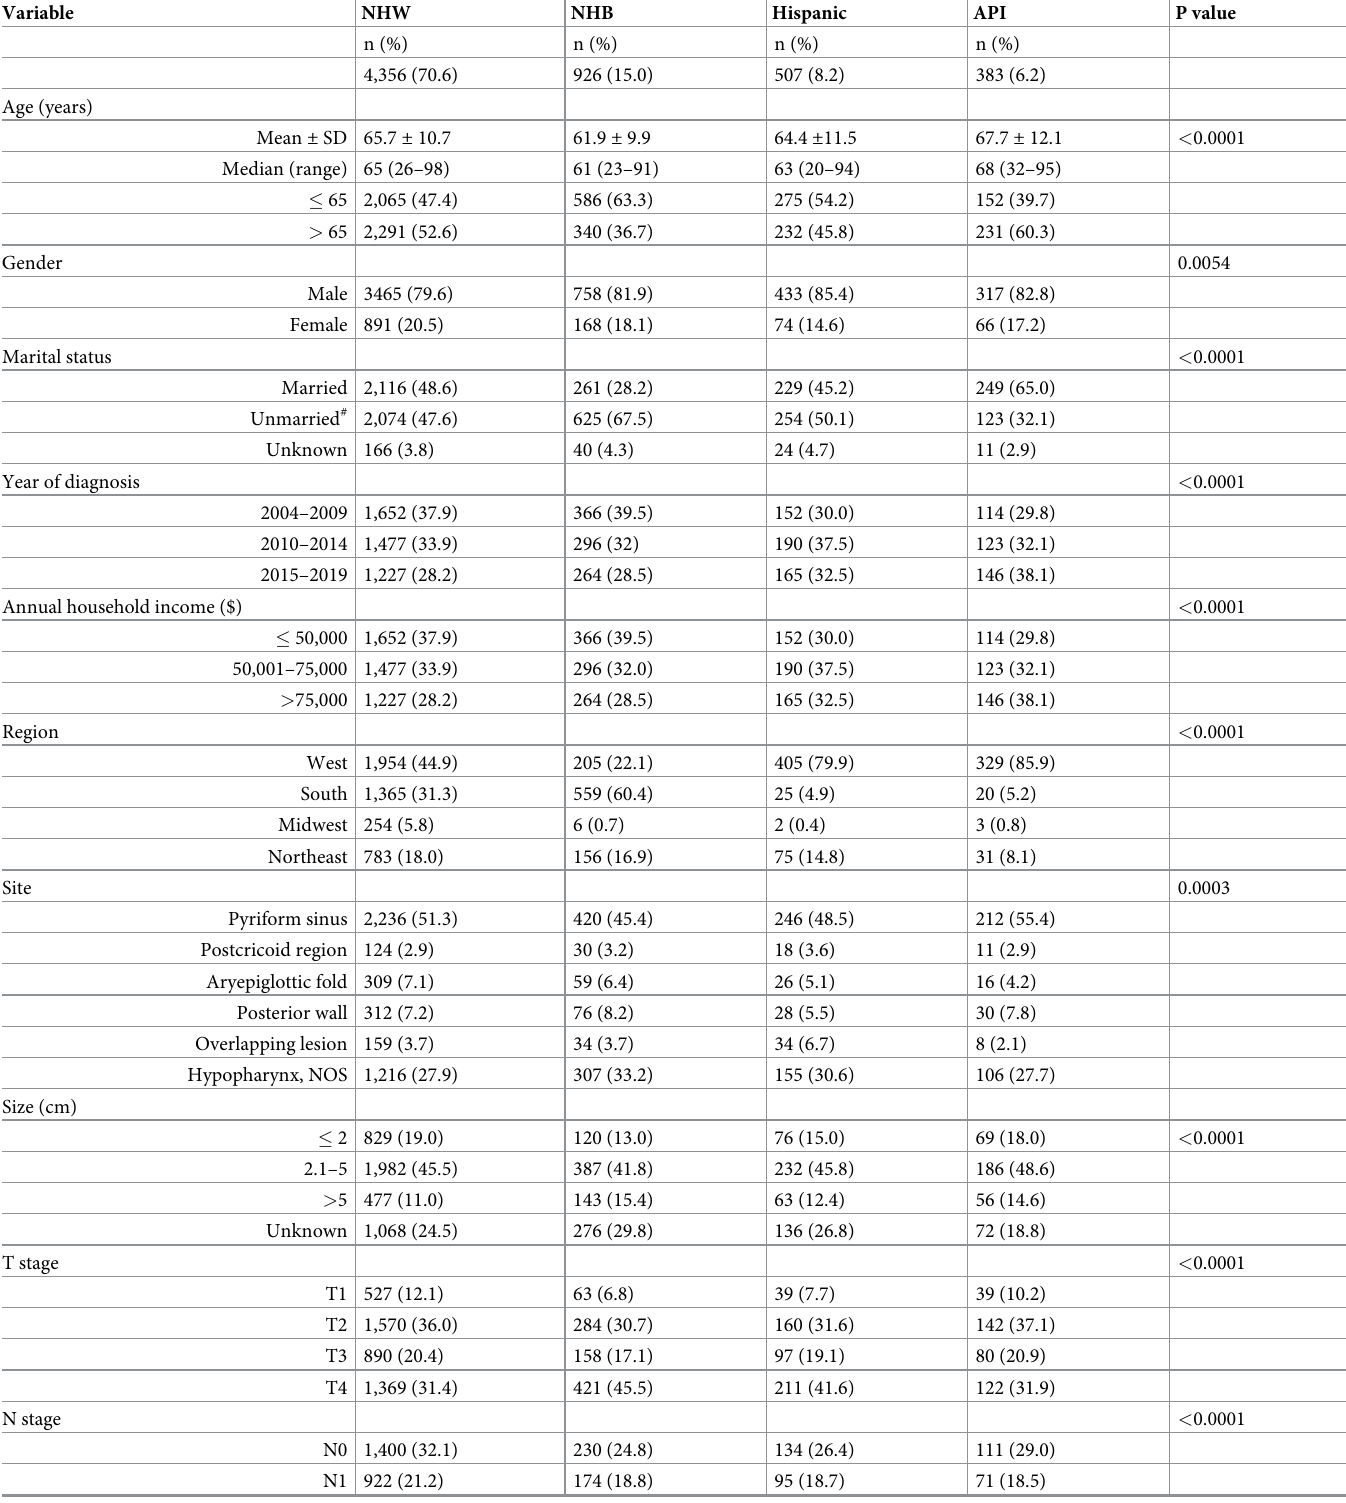
Table 3. Racial disparity of clinicopathological features in HPSCC patients diagnosed during